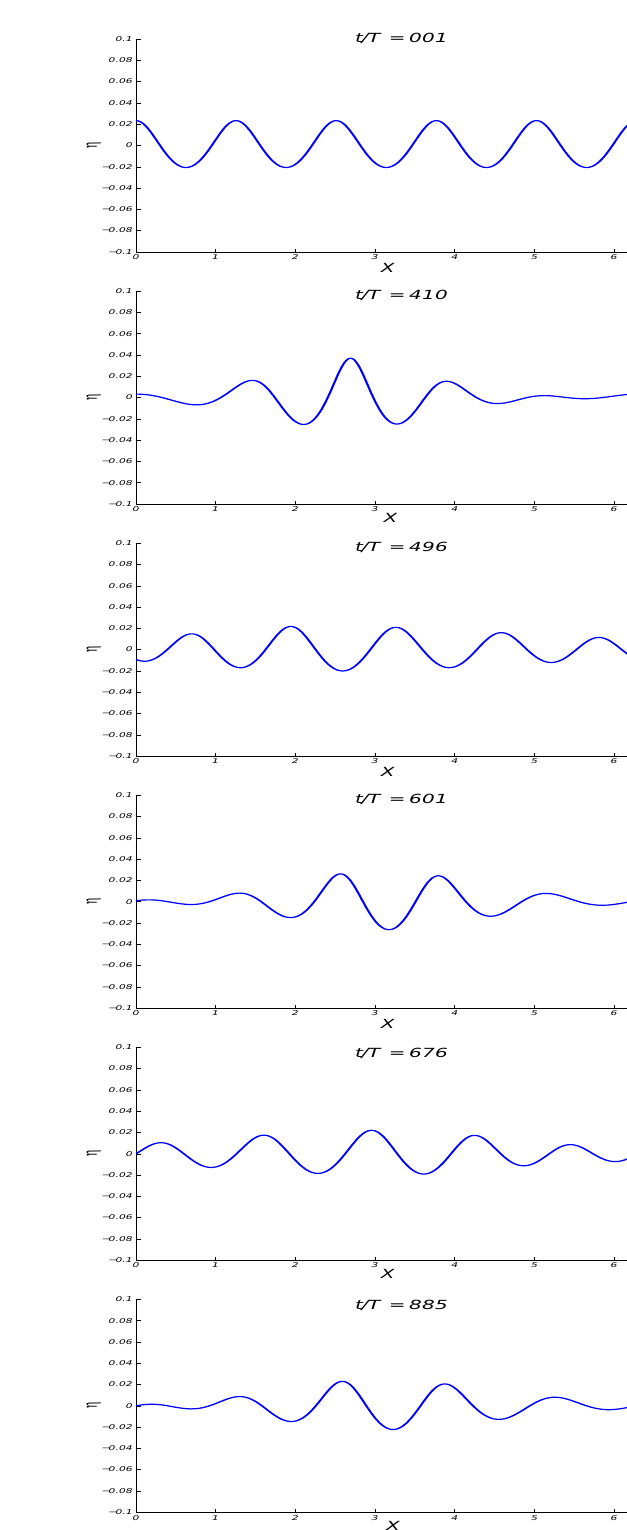
Fig. 3. Surface wave profiles at different times, obtained while propagating initial condition corresponding to seeded case with ( 𝒜 , Ω) = (4 , 0 . 59) . From top to bottom 𝑡/𝑇 = 1 , 291 , 436 , 596 , 793 , 846 .